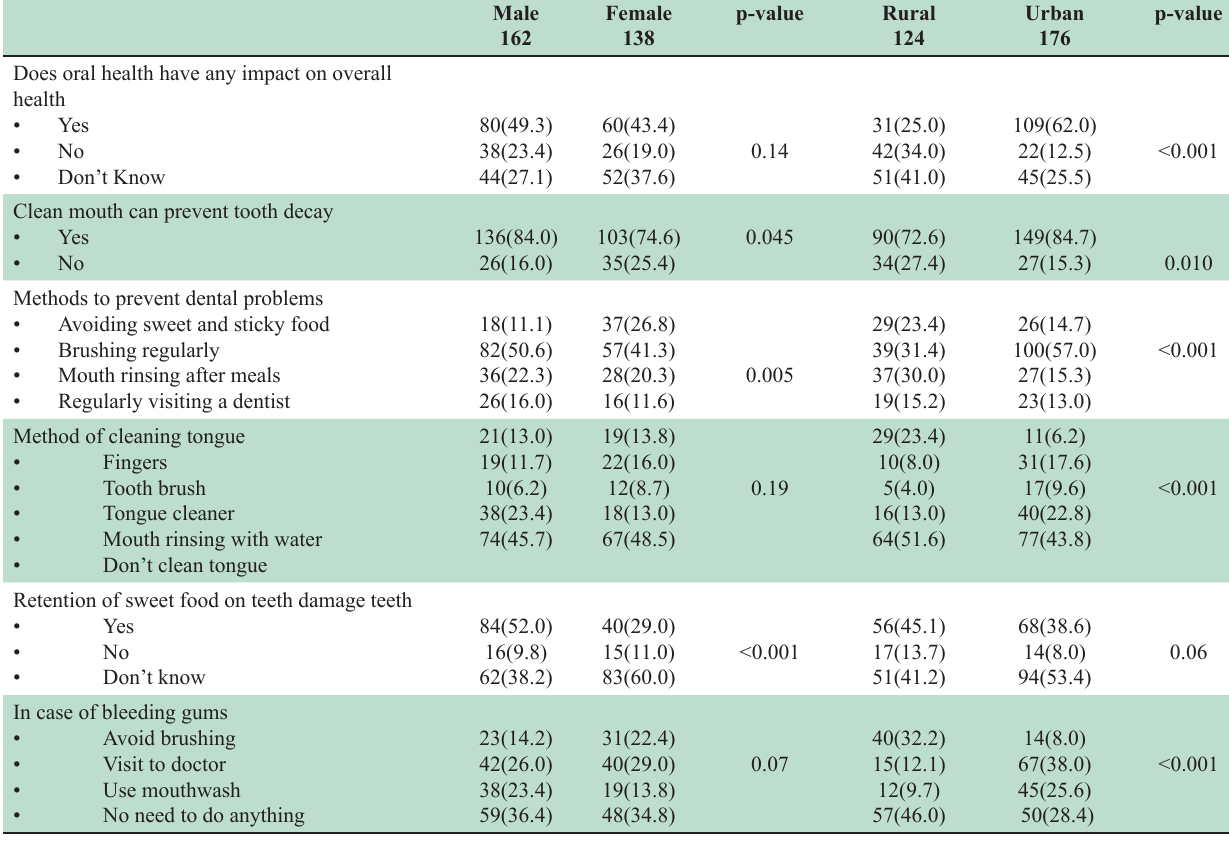
Table-II: Comparison of Oral hygiene knowledge between study participants (n=300).